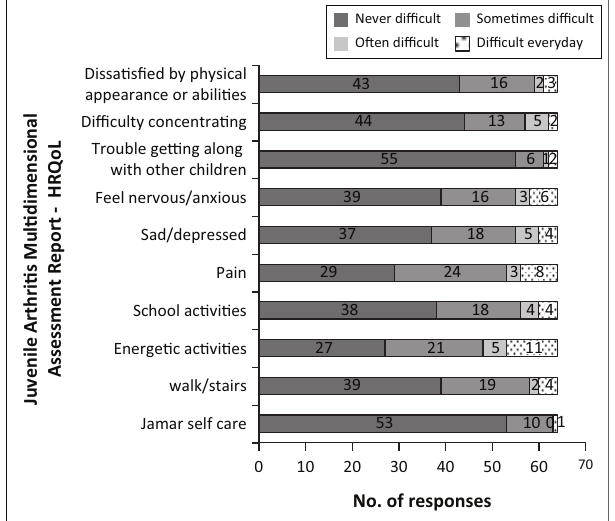
FIGURE 2: Number of responses in each level of Juvenile Arthritis Multidimensional Assessment Report Health-Related Quality of Life. N =